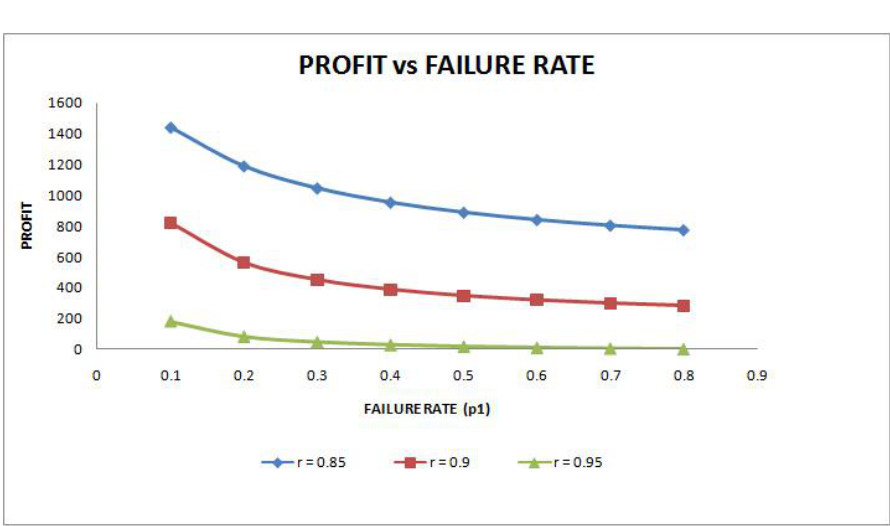
Fig. 3. Profit vs failure